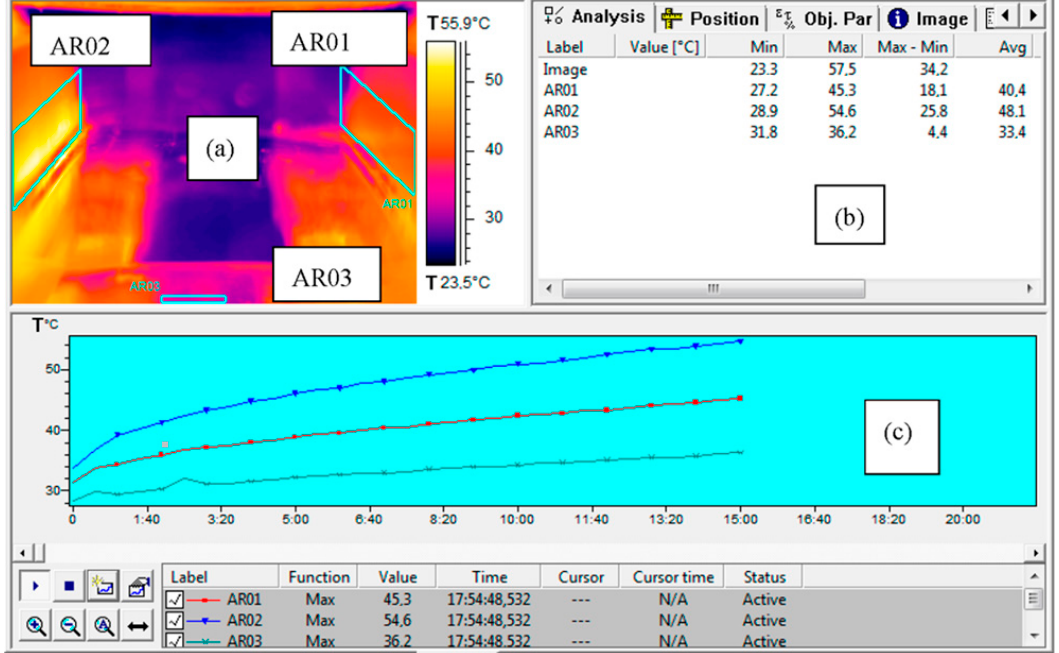
Figure 15. Temperature Measurement (5 kW) of each leg using IGBTs FF300R12KS4. ( a ) Infrared image of power stage; ( b ) Maximum, minimum and difference values measured in each AR0x zone; ( c ) Temperature evolution in each leg and heatsink; blue: AR02 (Q 1 –Q 2 ); red: AR01 (Q 3 –Q 4 ); green: AR03 (heatsink).